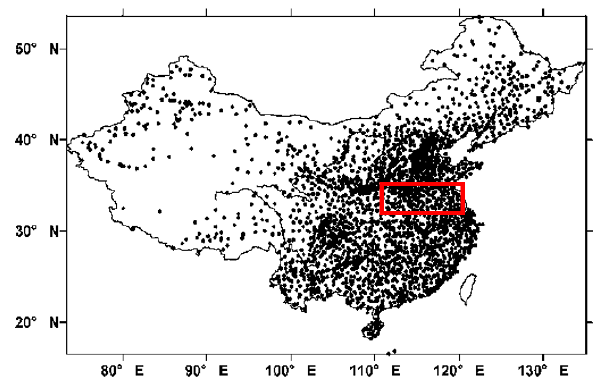
Figure 1. Spatial distribution of rain gauge stations in China, in which the red box denotes the HRB where there are 189 stations.